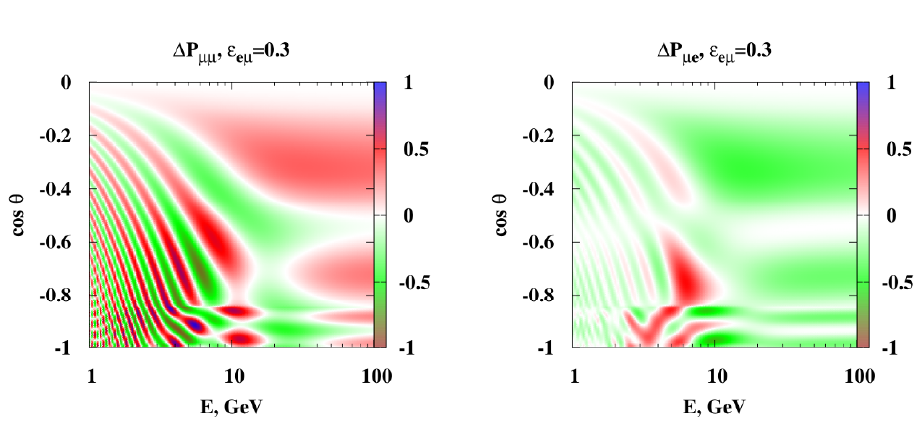
Figure 2 . The same as in (cid:12)gure 1 but with (cid:15) e(cid:22) = 0 : 3.